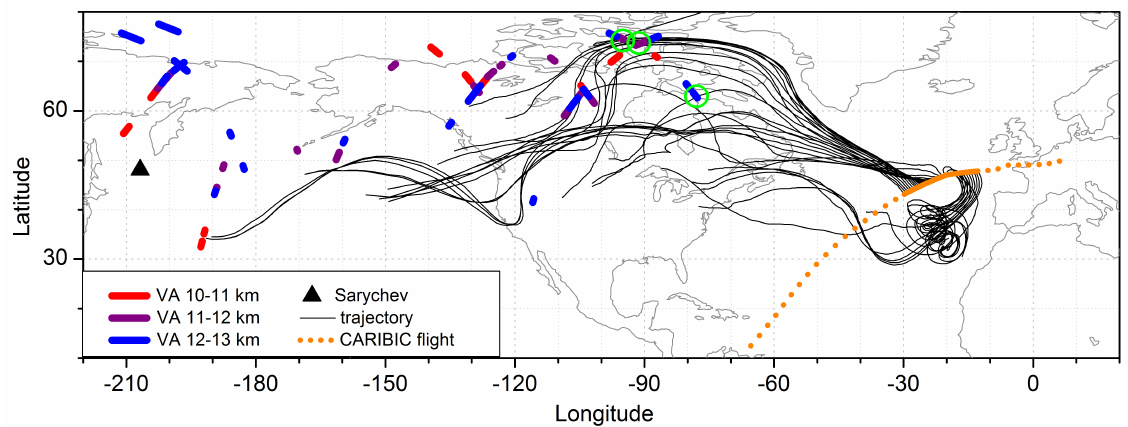
Fig. 2. Air-mass back-trajectories (thin black lines) calculated for one sample collected during the first CARIBIC flight from Frankfurt to Caracas at 23 June 2009 (orange dotted line) following the eruption of Sarychev, combined with volcanic aerosol (VA) layers at 10–13km altitude (colored lines) obtained from CALIPSO lidar measurements at 21 June 2009. Green circles indicate where trajectories and aerosol layers intersect horizontally and